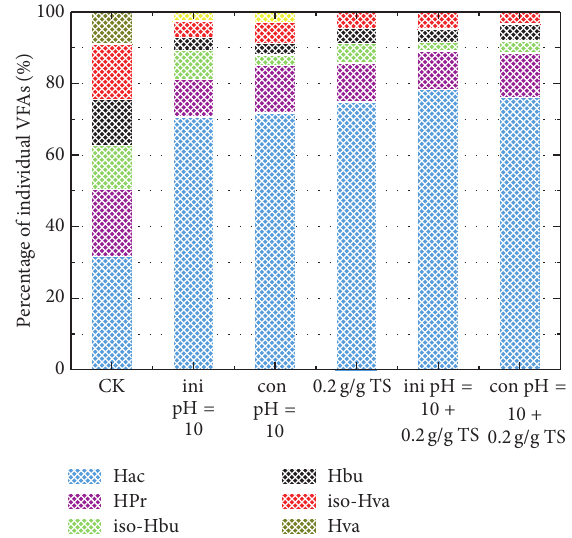
Figure 4: Composition of VFAs from codigestion of FW and SS (3 :2) with different treatments at 8 d. The pH control was divided into initial pH 10 adjustment (ini pH = 10) and constant pH 10 adjustment (cons pH = 10). The 𝛽 -CD dosage was 0.2 g/g total solid (TS). The mixture of FW and SS without any treatment was set as control test